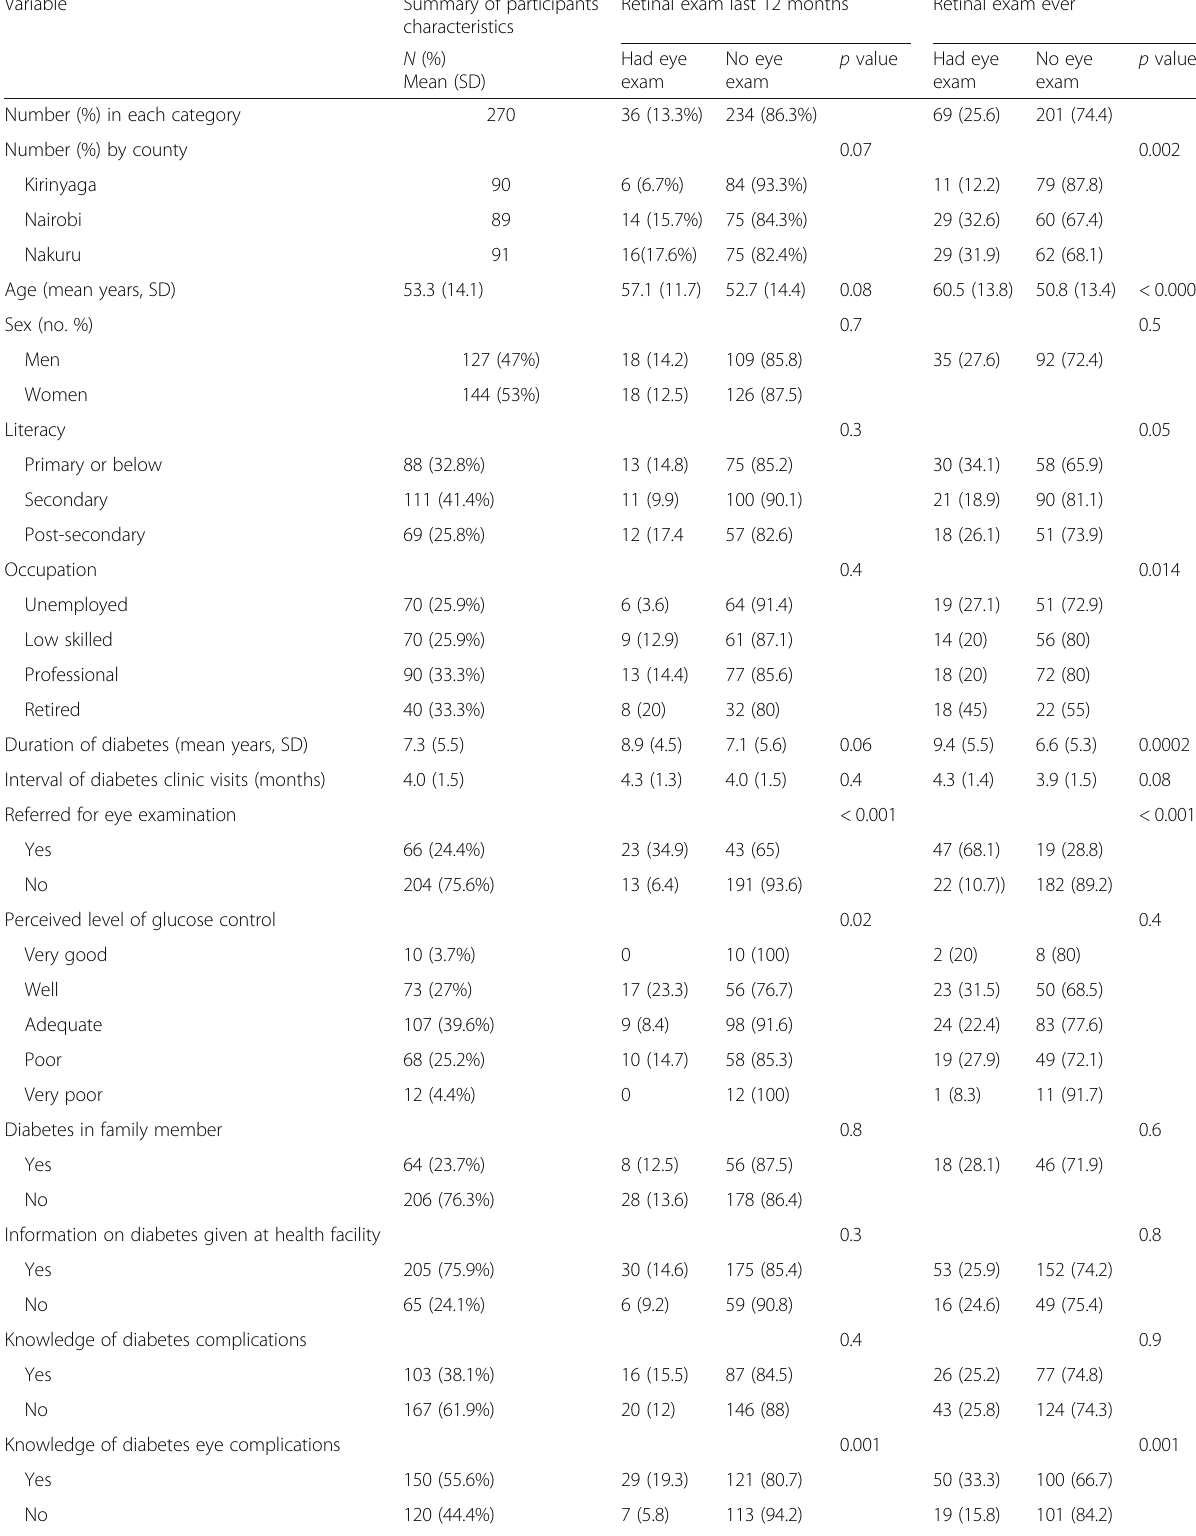
Table 2 Patient characteristics and association with eye